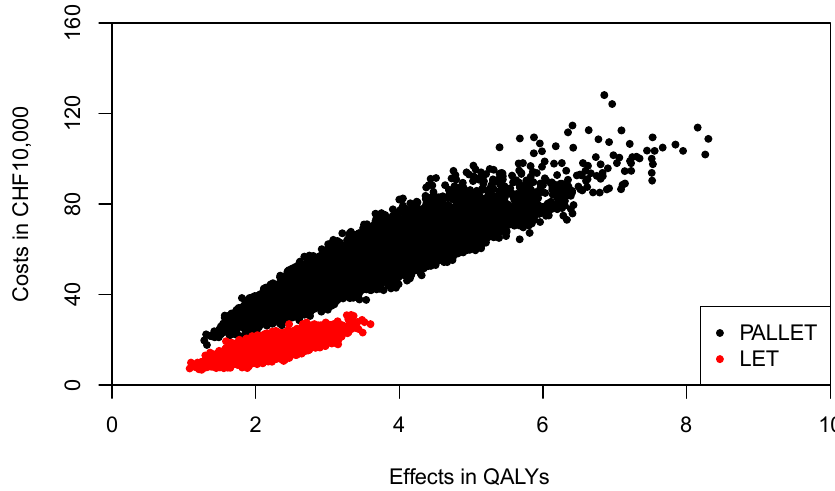
Figure 4. Joint distribution of total costs and effects of PALLET (palbociclib and letrozole) versus LET (letrozole) in patients with metastatic ER + HER2- breast cancer. One Swiss Franc (CHF) corresponds to $US 1.07.